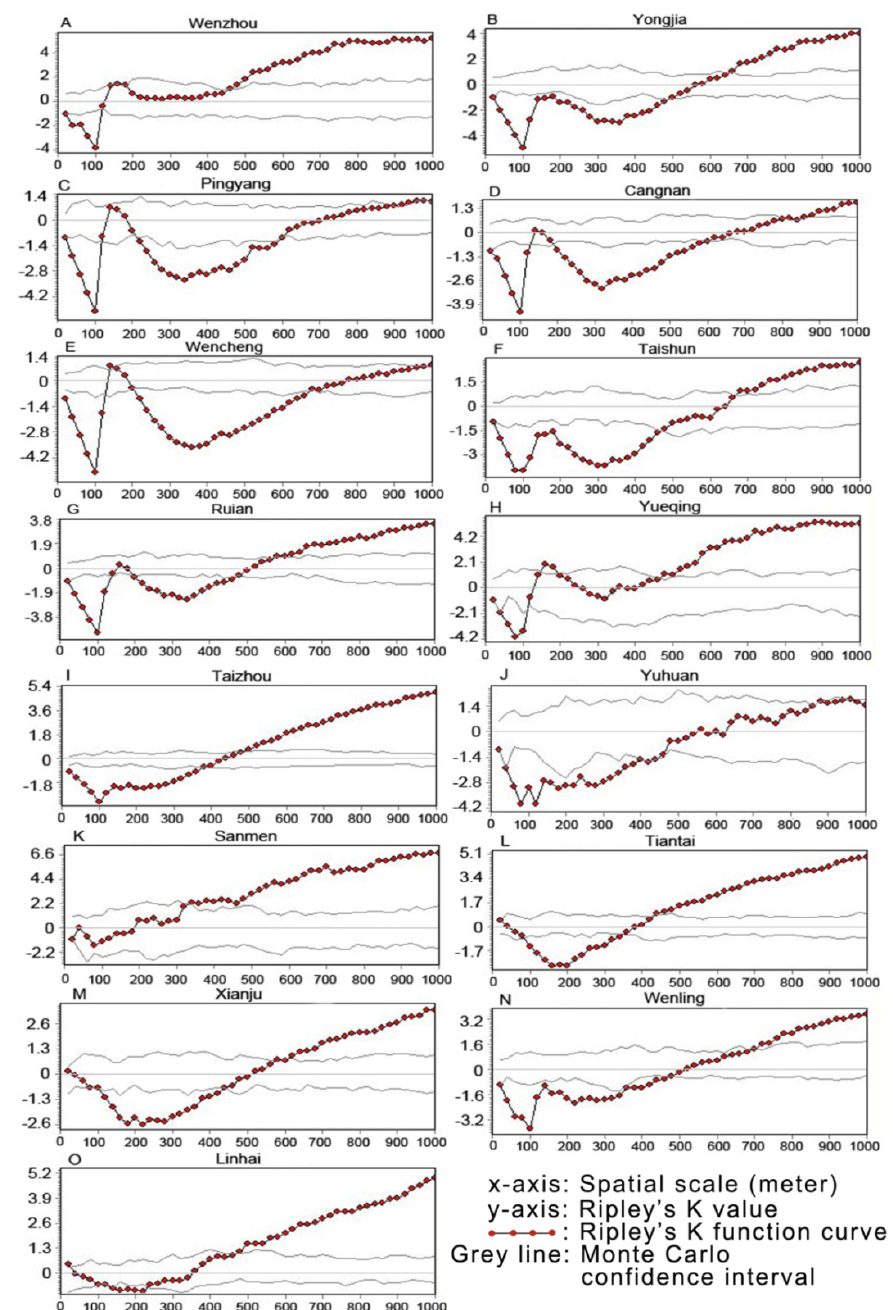
Figure 3. Ripley’s K point pattern of human settlements in Wen-Tai region, China. Figures show the Ripley’s K function curve (grey line with red dots) between the two grey lines as the Monte Carlo confidence interval in different